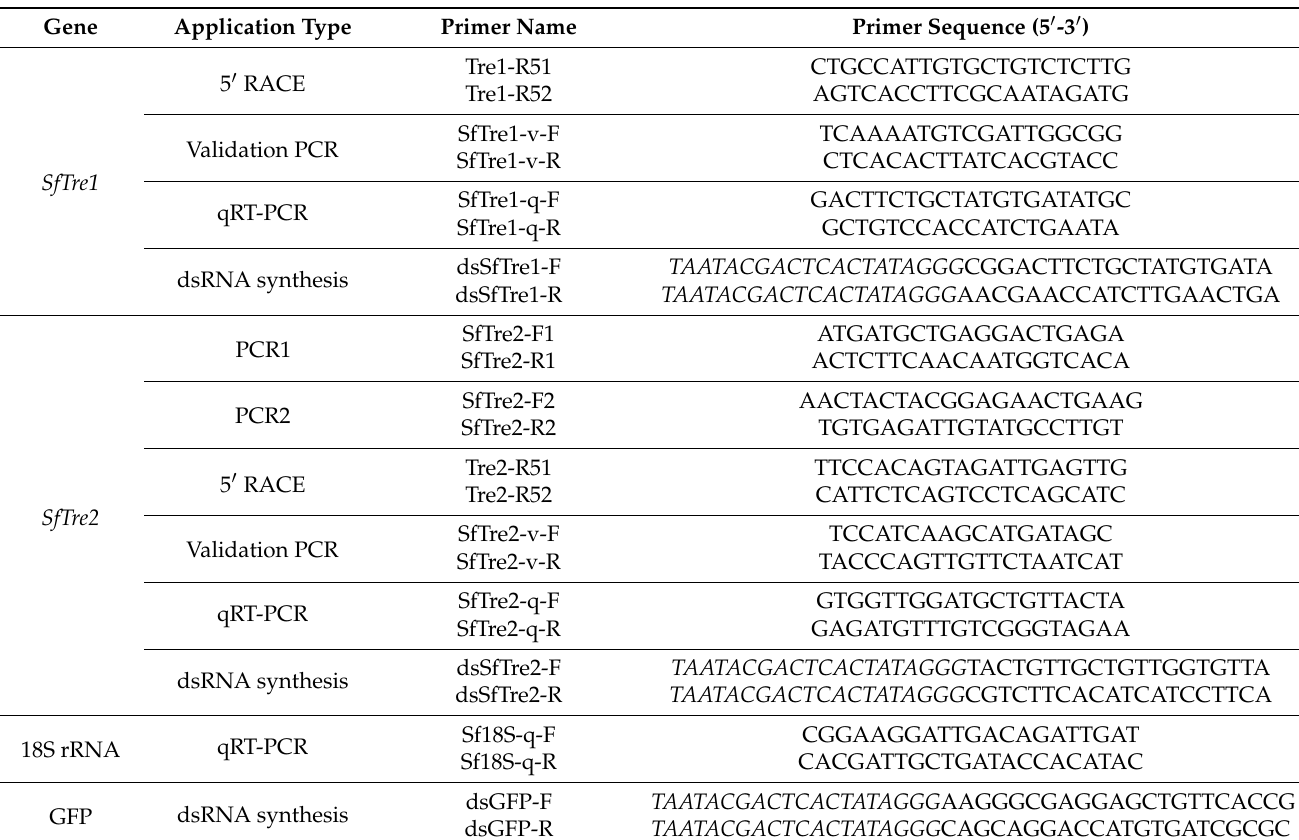
Table 1. Primers used in the